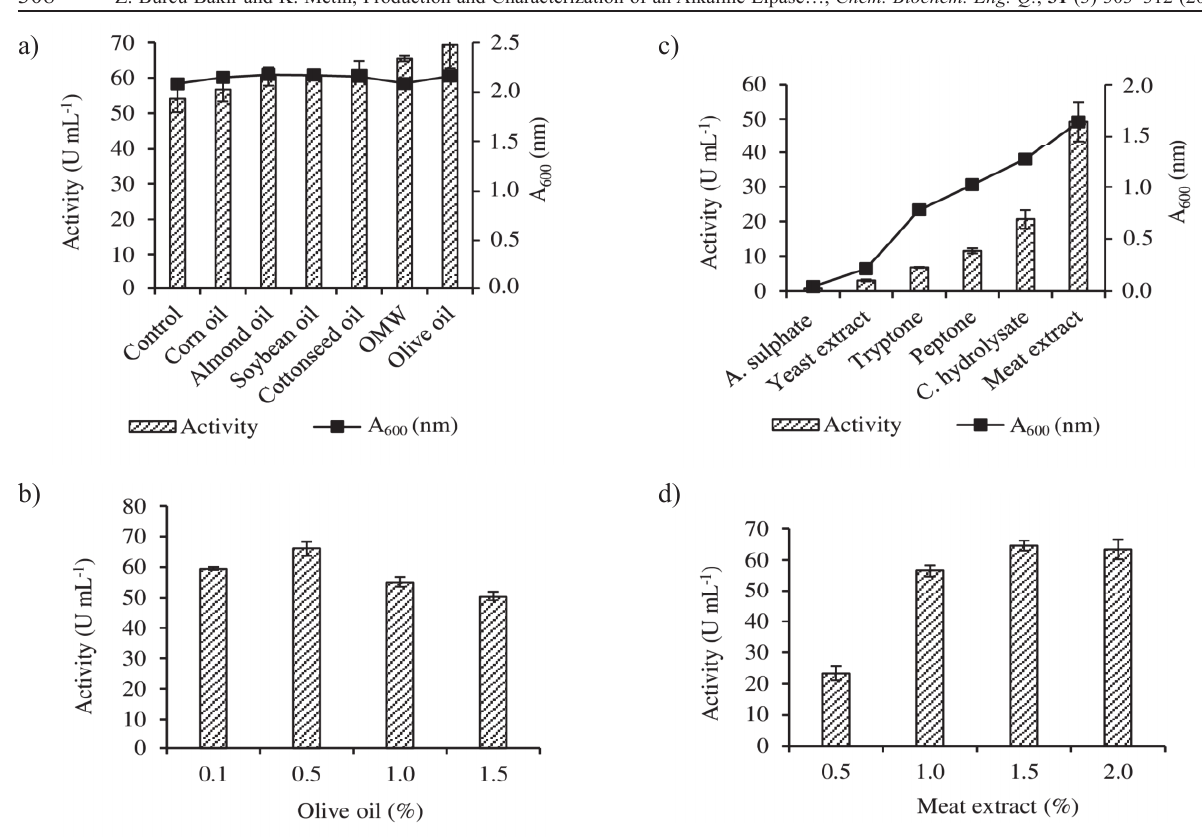
Fig. 3 – Effect of carbon and nitrogen sources on lipase production a) Anoxybacillus sp. HBB16 was grown at 50 ° C and pH 6.5 for 24 h on LB medium containing 0.5 % gum arabic with the addition of the indicated carbon source at a concentration of 0.1 % b) Effect of olive oil concentration on lipase production. Anoxybacillus sp. HBB16 was grown at 50 ° C and pH 6.5 for 24 h on LB me- dium containing 0.5 % gum arabic with the addition of olive oil at different concentrations c) Anoxybacillus sp. HBB16 was grown at 50 ° C and pH 6.5 for 24 h on medium containing 0.1 % olive oil, 1 % NaCl, 0.5 % gum arabic with the addition of the indicated nitrogen source at a concentration of 0.5 % d) Effect of meat extract concentration on lipase production. Anoxybacillus sp. HBB16 was grown at 50 ° C and pH 6.5 for 24 h on medium containing 0.1 % olive oil, 1 % NaCl, 0.5 % gum arabic with the addition of meat extract at different concentrations. Values are the means of three different